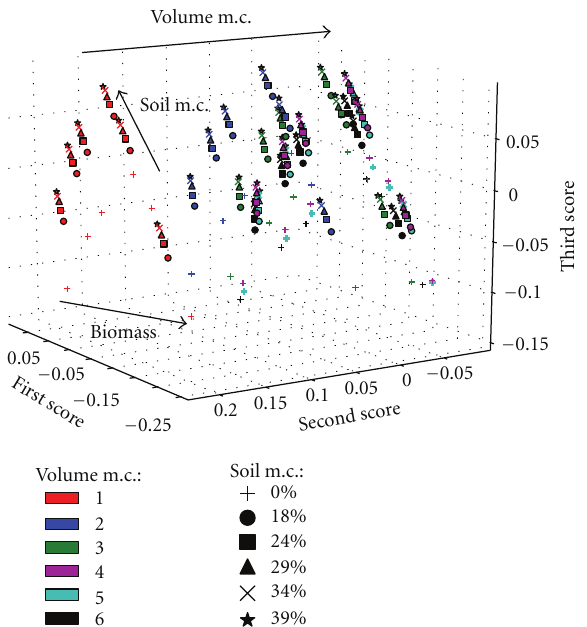
Figure 14: Result of a PCA on radar HH, HV radiometry and optical NDVI, GVMI, and NINSOL indexes, for forests with needles. The groups of same biomass are the same as in Figure 13. Figure 15: Result of a Canonical Analysis performed on biomass,